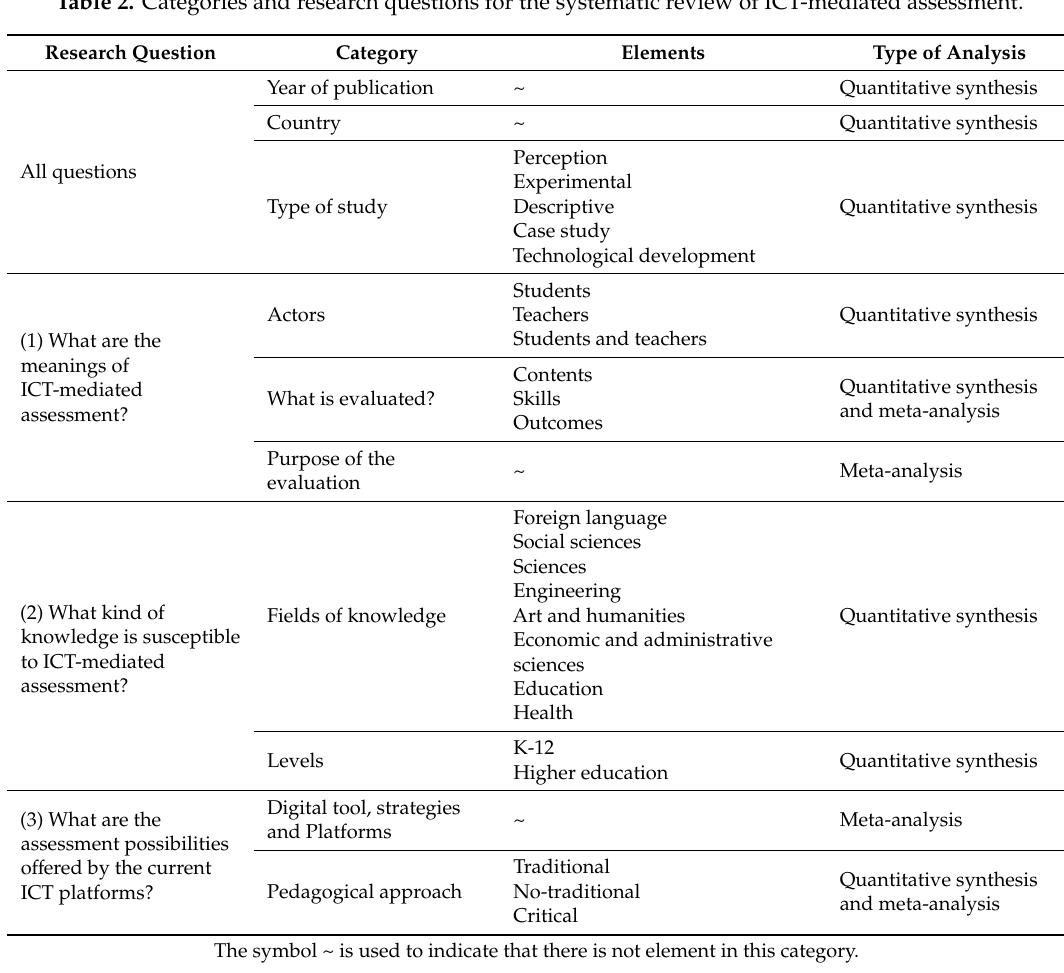
Figure 3. Distribution of retrieved research articles per continent. The selected papers present descriptive, experimental, perception, case studies, and some works describing technological development, such as digital tools, platforms, web, or mobile applications. Figure 4 shows the percentages of documents in each type of study. Descriptive studies analyze how the use of digital tools or platforms affect student performance [20–24], describe online course designs and their assessment components [25,26], as well as present qualitative analyses of the possibilities and limitations of virtual assessment [27–33], and analysis of reliability and validity [34,35]. Of the selected articles, 39 correspond to descriptive studies. On the other hand, experimental studies (31 selected articles) compare the performance of the students using ICT-mediated assessment strategies [36–40]; some of these studies use control groups that develop the assessment activities as usual in the course [41–47], for example, in a face-to-face setting [48–50]. We also found 34 studies of perception, which seek to determine the acceptability, engagement, opinion, and valuation of digital tools, platforms, or ICT-mediated assessment strategies from students and teachers (e.g., [51–54]). Other articles present the design and implementation of digital tools, web or mobile platforms, or software supporting ICT-mediated assessment; 40 articles were found in this category (e.g., [55–58]). Finally, the selected articles include 6 case studies, which use few data or a small sample population to analyze online evaluation [59–61].